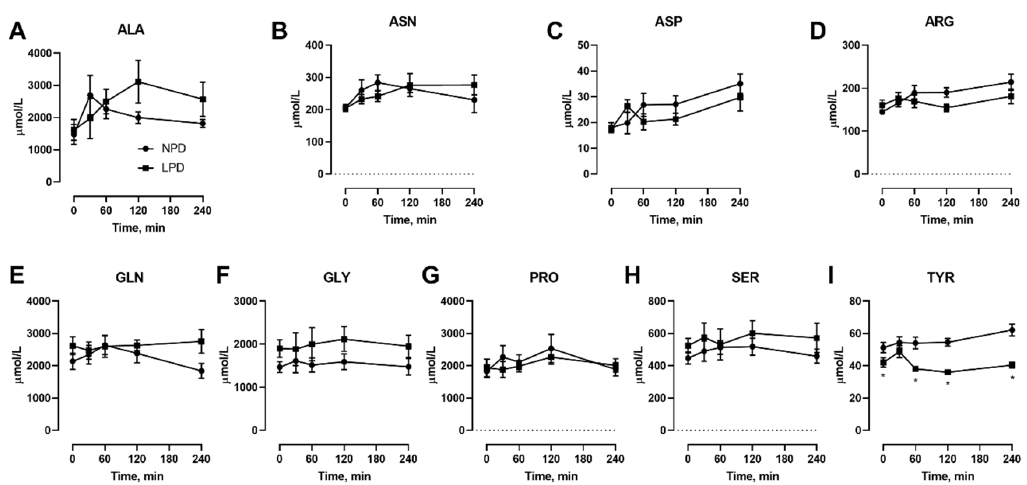
Figure 3 . Effects of dietary protein restriction on blood serum non-essential amino acids during isocaloric meal feeding. Young men ( n = 5) underwent a 7 d period of consuming a protein-restricted diet, with isocaloric meal tolerance tests conducted before and at the end of the 7 d period, with blood samples drawn at selected time points during the test. Blood serum amino acid levels including alanine ( A ), asparagine ( B ), aspartate ( C ), arginine ( D ), glutamine ( E ), glycine ( F ), proline ( G ), serine ( H ), and tyrosine ( I ) were measured. NPD: normal-protein diet; LPD: low-protein diet. Data are the mean ± SEM. Two-way RM ANOVA, different than NPD: * p < 0.05.